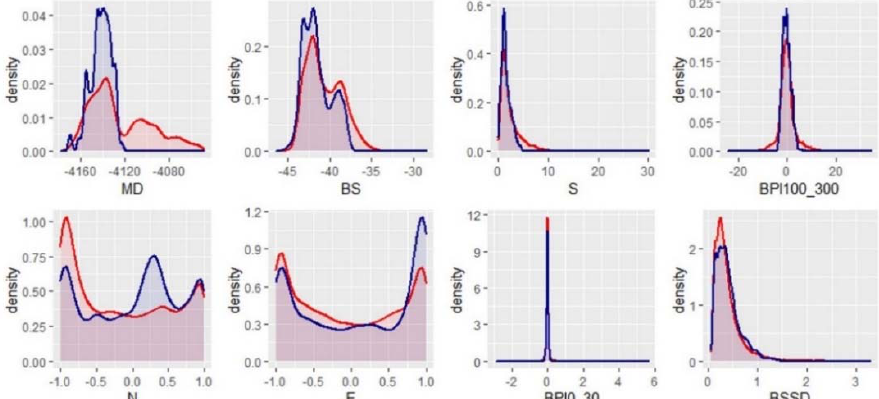
Figure 11. Top left: the dissimilarity index (DI) between training samples and the study area resulted from the QRF model weights. Top right: the random-CV has the most limited AOA, which is restricted to the area directly around the training samples. For block- and cluster-CV (middle left), the prediction error is comparable for the entire DEA and a small part of the DEA-NE (0 = Not applicable, 1 = Applicable). Without the mean depth (MD) as predictor variable, the AOA increases (middle right). The spatial- and cluster-CV have very similar AOA statistic values (r = 0.96, p < 2.2 × 10 − 16 ). Thus, only the cluster-CV AOA is presented in the density plots (bottom). The density plots show the difference between the training samples (blue) and the entire study area (red). Mean depth (MD) has the most significant difference, followed by backscatter (BS), northness (N), and eastness (E).